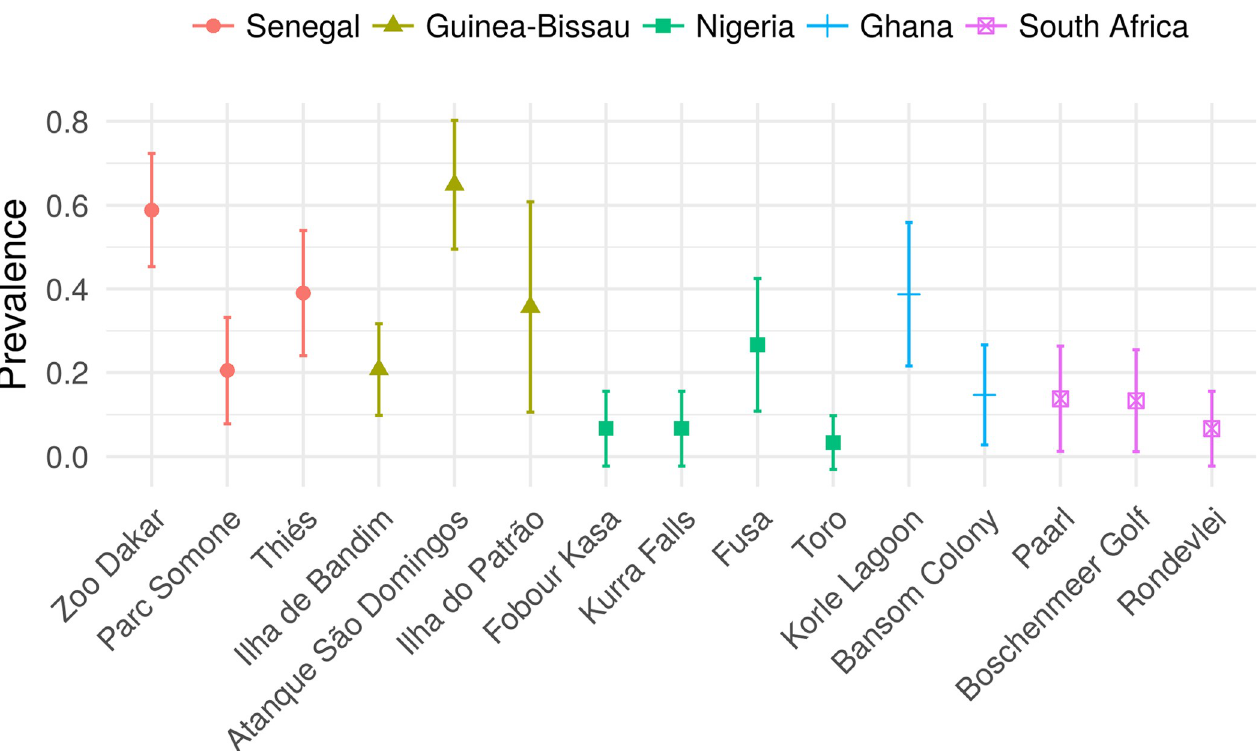
Fig 3. Spatial distribution of prevalence and relationships with environmental variables. Prevalence of Plasmodium with approximate 95% confidence intervals (computed using Gaussian approximation) in cattle egret colonies from five countries in central-western and southern Africa.